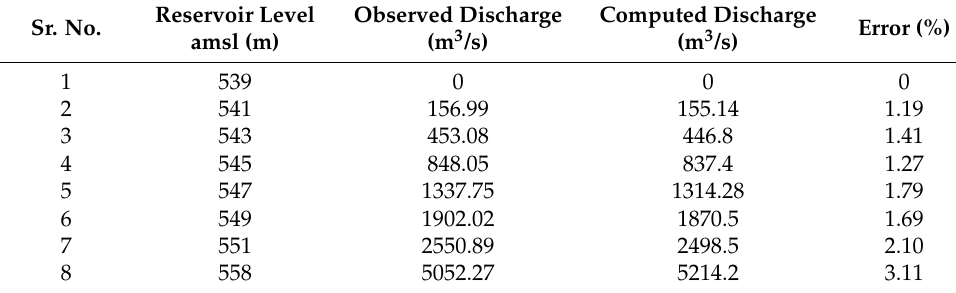
Table 2. Comparison between observed and computed discharge. Sr.